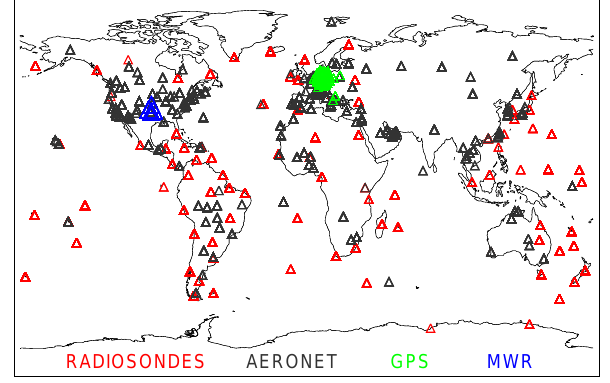
Fig. 9. Geographic distribution of used validation data over